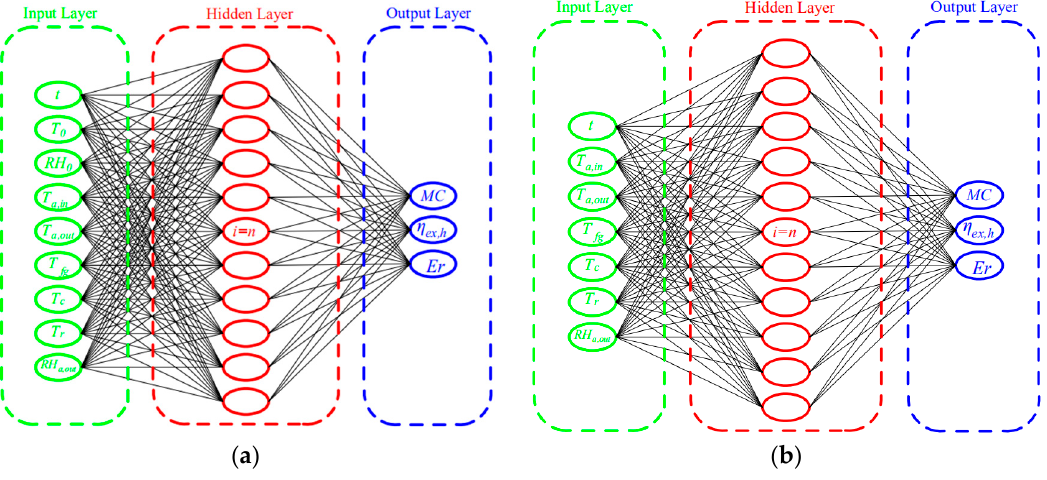
Figure 3. The established IANN model ( a ) and OANN model ( b ).